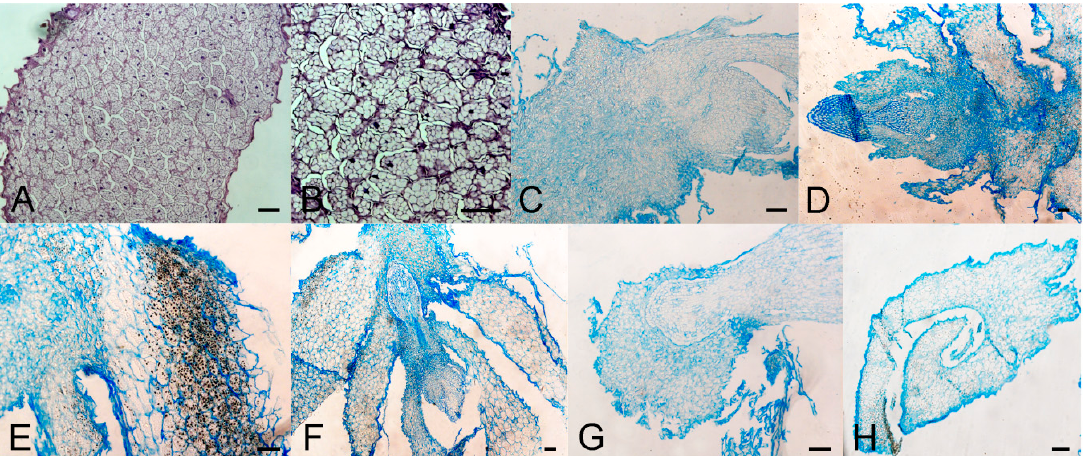
Figure 2. Morpho-anatomical study of F. meleagris bulbs sprouting after 5 weeks of culture with GA 3 and GA inhibitors. ( A , B ) Cross sections of non-sprouted bulbs grown on medium with GA 3 and cultured at 7 °C. ( C , D ) Cross sections of sprouted bulbs grown on medium with GA inhibitors: paclobutrazol ( C ) and ancymidol ( D ) cultured at 7 °C. ( E – H ) Cross sections of sprouted bulbs cultured on medium with GA 3 ( E , F ), paclobutrazol ( G ) and ancymidol ( H ) at 24 °C. Scale bars = 100 μ